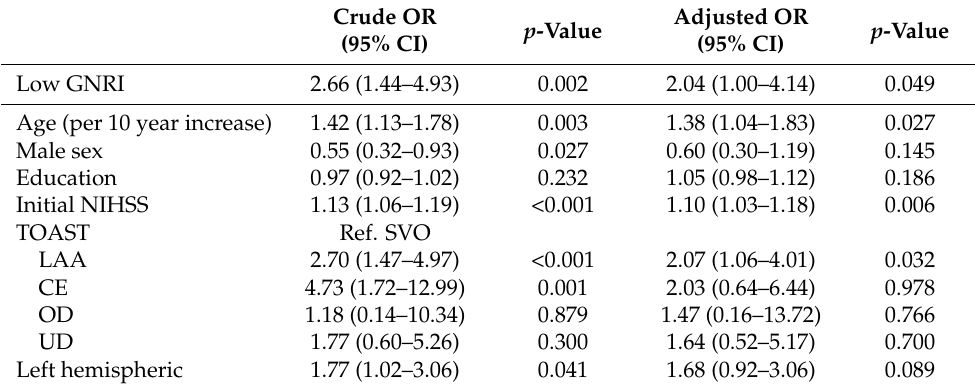
Table 3. Multivariable analysis for possible predictors of PSCI.